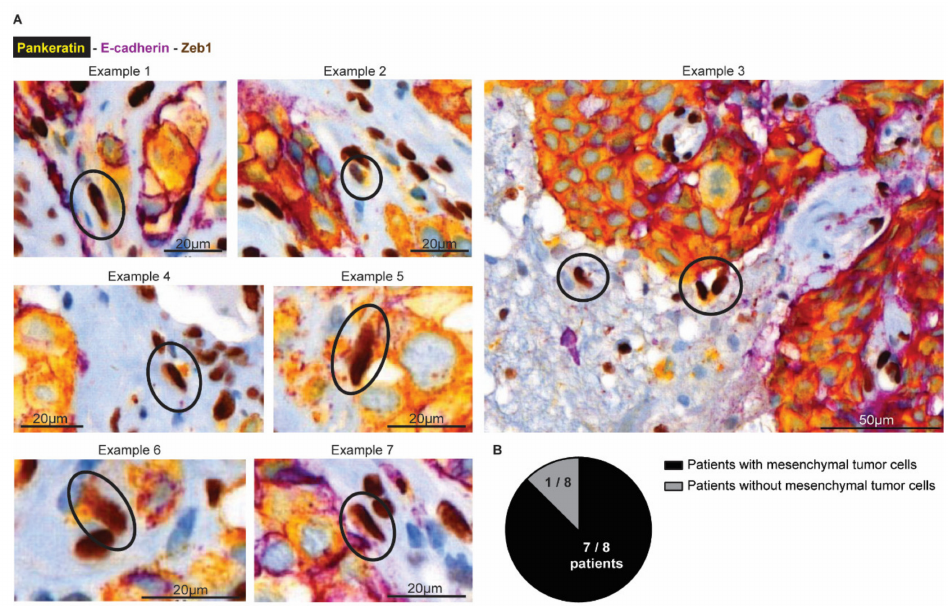
Figure 7. Mesenchymal tumor cells are present at the invasive front in human BCBM. ( A ) Multiplex immunohistochemistry imaging of Pankeratin (yellow), E-cadherin (purple) as markers for epithelial cells and Zeb1 (DAB) to mark cells in a mesenchymal state. ( B ) Quantification of the number of patients where mesenchymal tumor cells were observed in the brain